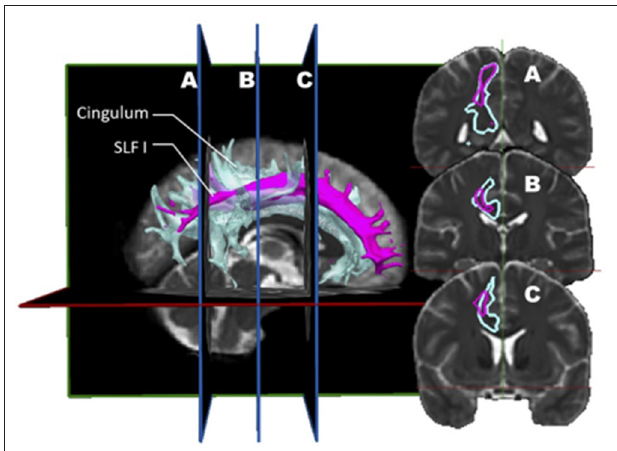
FIGURE 3 | In vivo fiber tractography of the right SLF I (pink) and the right cingulum (light blue) represented by volume. A three-dimensional reconstruction of the SLF I and the cingulum is displayed at the left of the figure. The coronal sections of it (A, B and C) are represented on the right. On the coronal planes, it is possible to appreciate the great proximity between the fibers of the SLF I and those of the cingulum.